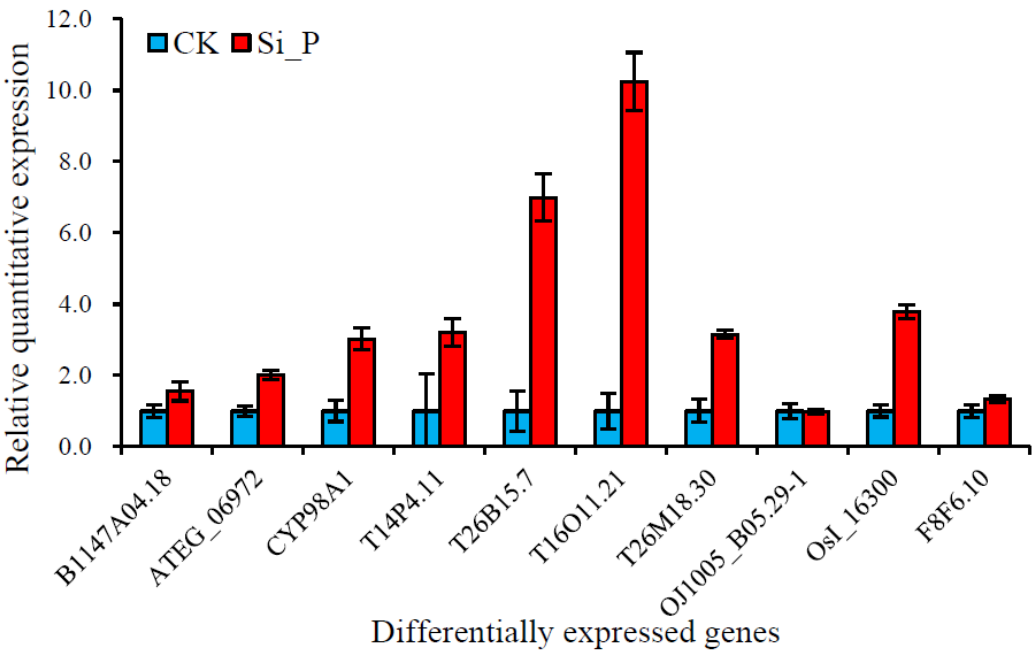
Figure 6. Gene expression analysis of DEGs through qRT-PCR. CK, no Pga inoculation; P, Pga inoculation.